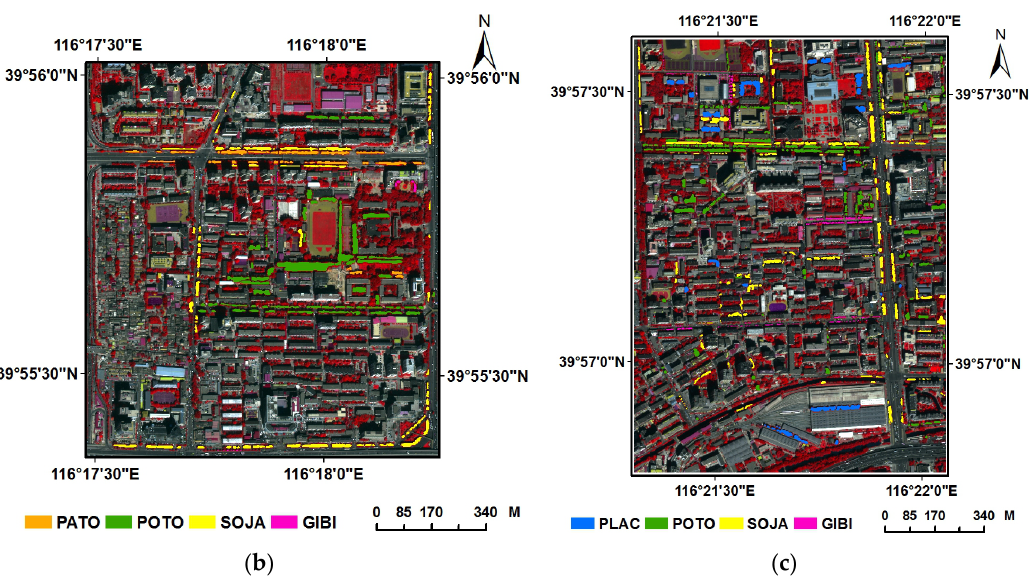
Figure 1. ( a ) Location of CNU and BNU study sites in Beijng city; ( b ) False color WV2 image over CNU study site with reference polygons; ( c ) False color composite WV2 image over BNU study site with reference polygons.